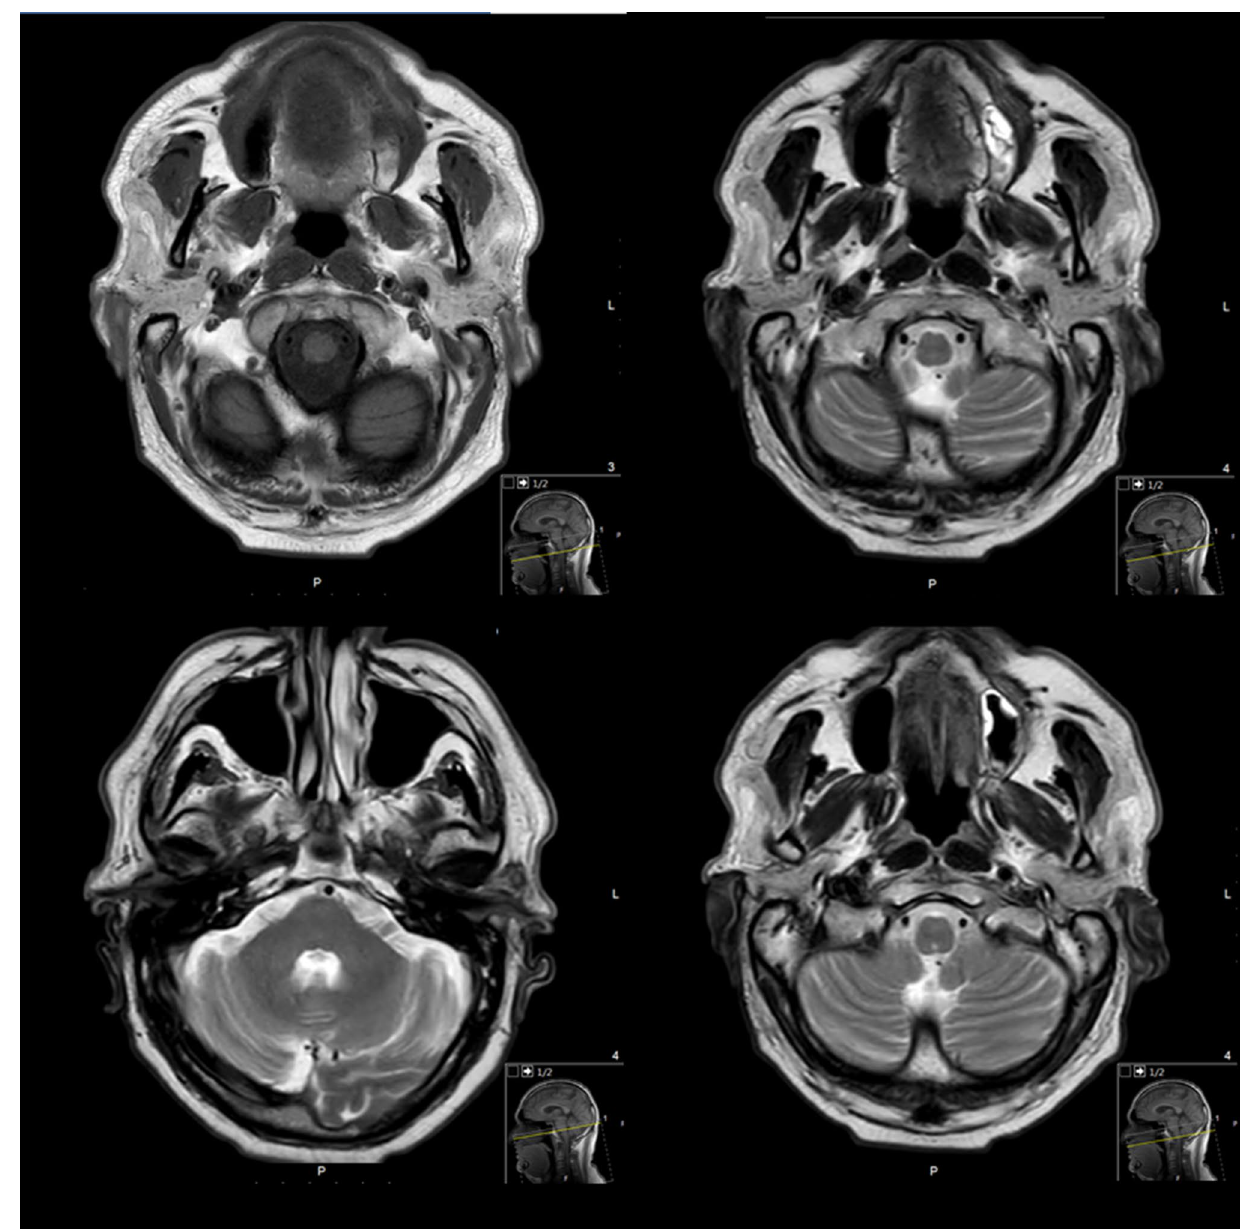
Fig. 5 MRI T1 and T2—after 2 cycles of the neoadjuvant treatment (after 8 weeks) shows significant decrease in the tumor or even its disap- pearance, attained a complete